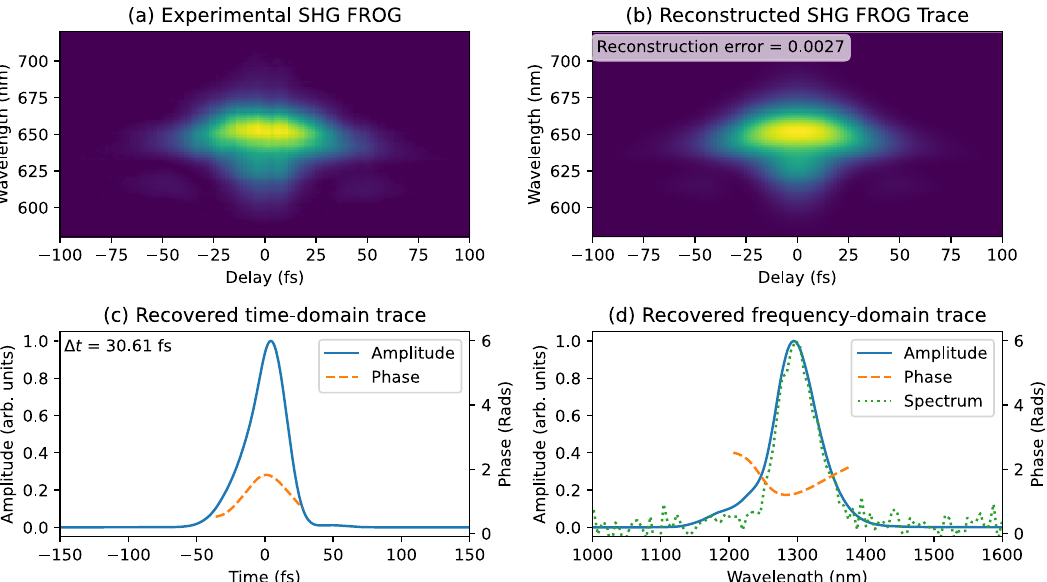
Fig. 3 SH-FROG measurements. a SH FROG traces experimentally acquired from our AZO fi lm. b Reconstructed FROG traces generated by the FROG retrieval algorithm (Retrieval error of 0.0027). c Recovered temporal amplitude (solid blue line) and phase (dashed orange line) pro fi les (FWHM time duration 4 t ¼ 30 : 61 fs ). d Recovered spectral amplitude (solid blue line) and phase (dashed orange line) pro fi les. This plot also reports the experimentally acquired input spectra (dotted green line) for comparison.